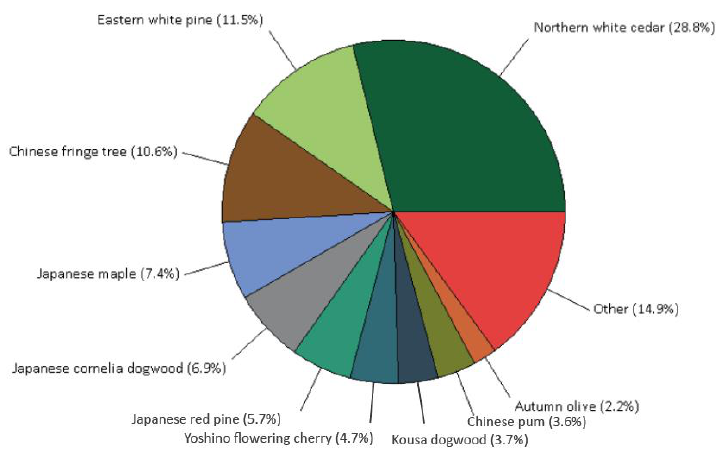
Figure 3. Population summary by species.